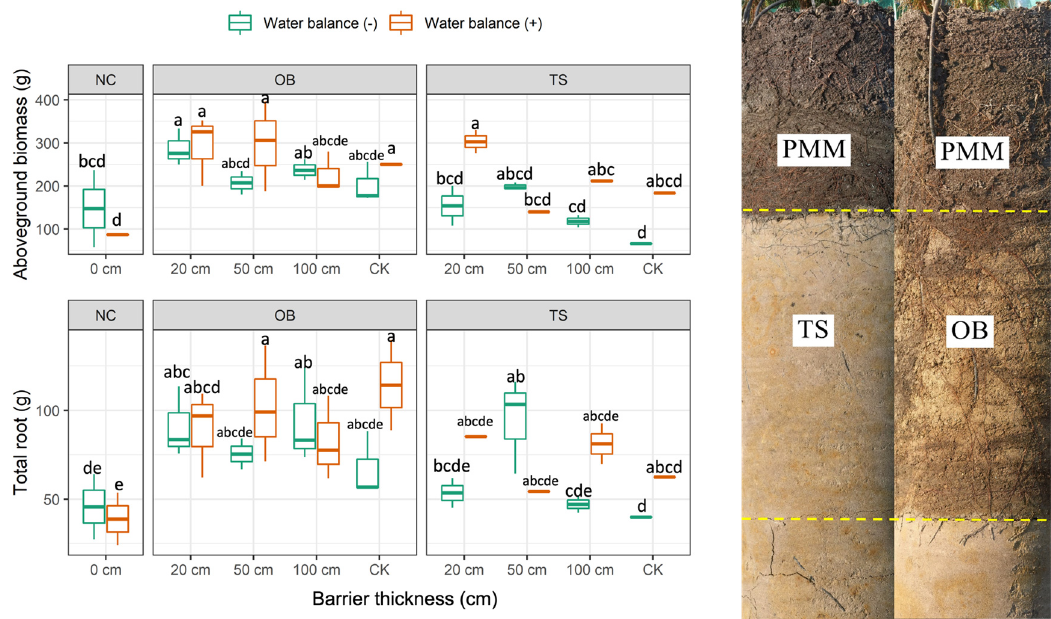
Figure 8. Plant growth after 3 simulated growing seasons. Different letters in a row indicate significant differences ( p < 0.05, ANOVA) among treatments at the same depth, which were derived by comparing all the values across the NC, OB and TS trials.